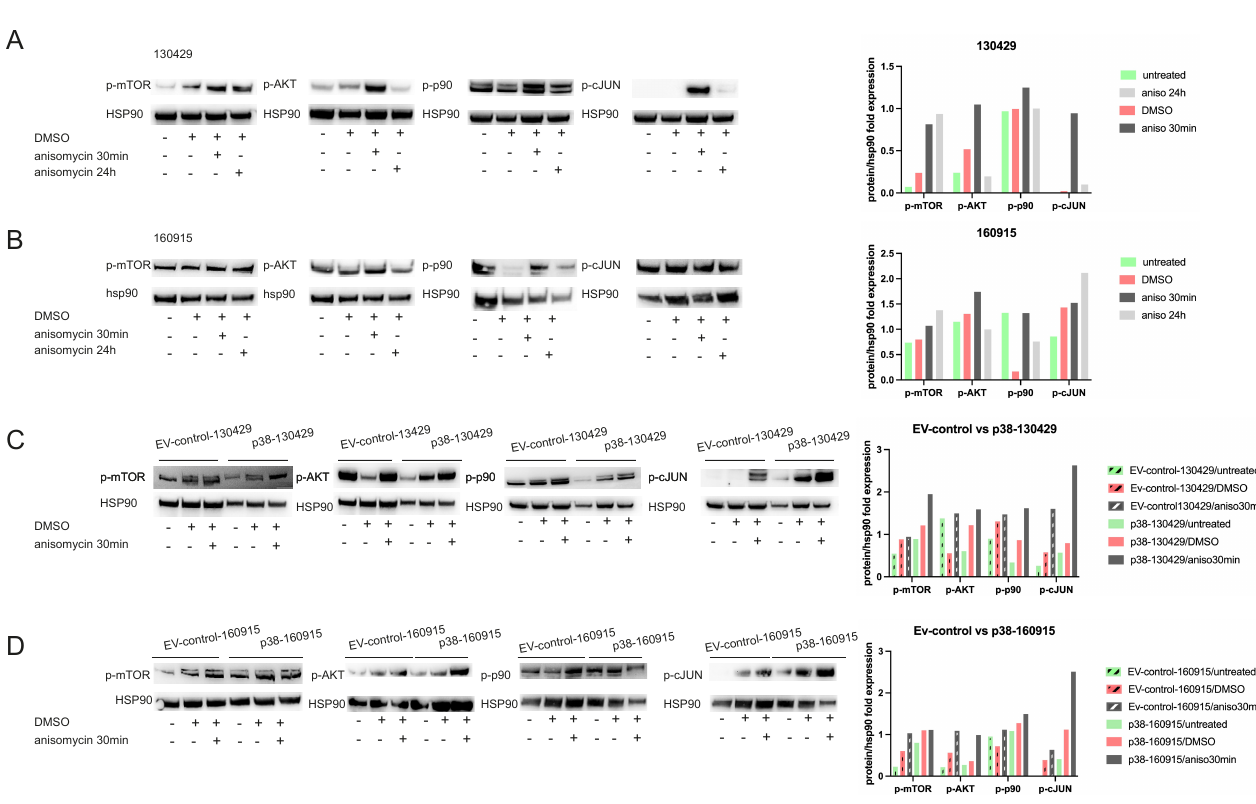
Figure 6. Transient phosphorylation of mTOR/AKT and cJUN pathway with short-term ani- somycin treatment and sustained phosphorylation of mTOR in long-term anisomycin-treated and p38–130429/160915 cells. ( A ): Protein expression of phospho-mTOR, AKT, p90, and cJUN with HSP90 as the loading control under untreated, DMSO, and 0.1 µ M anisomycin treatment for 30 min and 24 h in cell line 130429. Densitometry plot represents the expression of proteins as the fold change in relation to HSP90 expression. ( B ): Protein expression of phospho-mTOR, AKT, p90, and cJUN with HSP90 as the loading control under untreated, DMSO, and 0.1 µ M anisomycin treatment for 30 min and 24 h in cell line 160915. Densitometry plot represents the expression of proteins as the fold change in relation to HSP90 expression. ( C ): Protein expression of hosphor-mTOR, AKT, p90, and cJUN with HSP90 as the loading control under untreated, DMSO, and 0.1 µ M anisomycin treatment for 30 min in EV control–130429 and p38–130429 cell lines. Densitometry plot represents the expression of proteins as the fold change in relation to HSP90 expression. ( D ): Protein expression of phospho-mTOR, AKT, p90, and cJUN with HSP90 as the loading control under untreated, DMSO, and 0.1 µ M anisomycin treatment for 30 min in EV control–160915 and p38–160915 cell lines. Densitometry plot represents the expression of proteins as the fold change in relation to HSP90